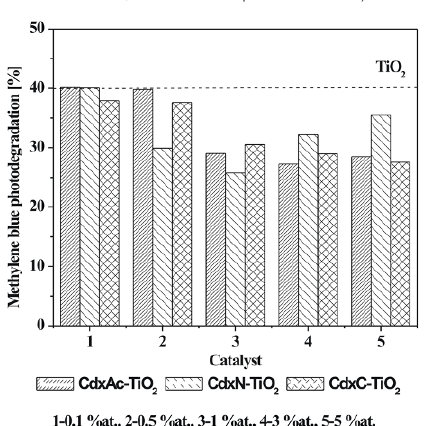
Figure 5. Photocatalytic degradation of Methyl orange vs. Cd doped TiO photocatalysts (where Ac, N and C represent 2 acetate, nitrate and respective